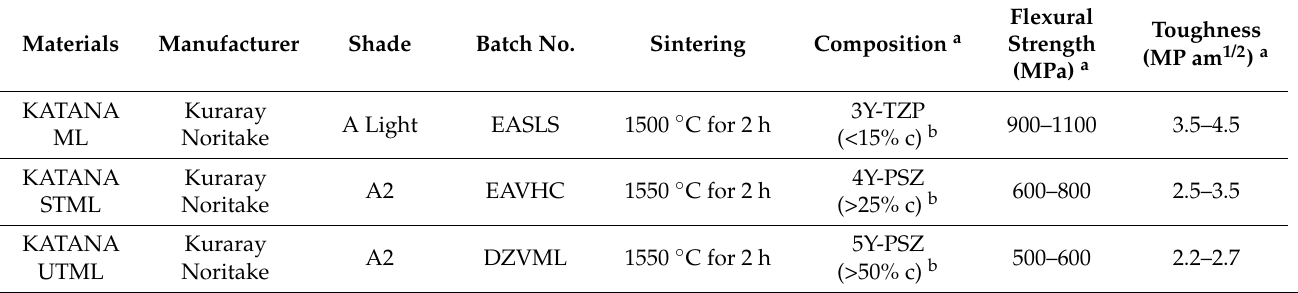
Table 1. Characteristics of the zirconia systems investigated.